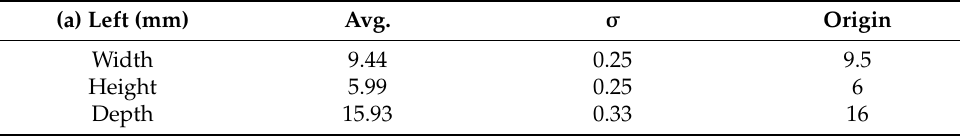
Figure 10. The optical microscope (OM) photograph for specimens. Table 2. Dimensions of the left part of the cage.